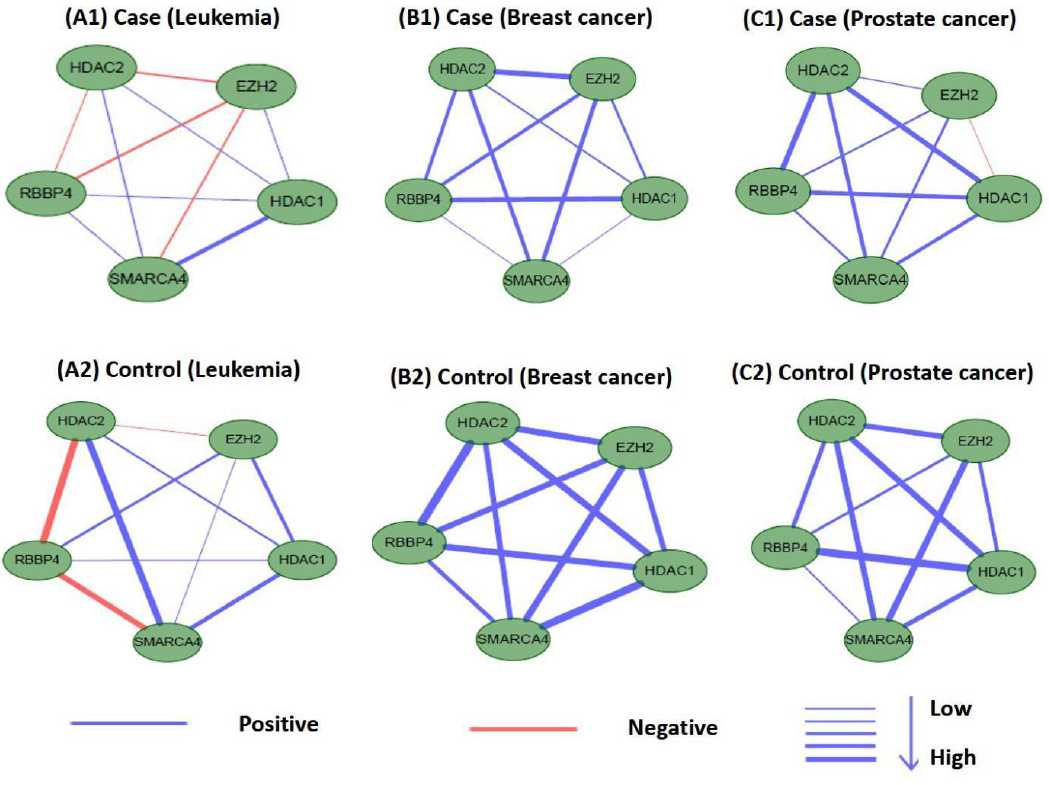
Figure 13. Differences in the co-expression network connections of M18 in normal and tumor-based states under three different conditions (leukemia, breast cancer, and prostate cancer).